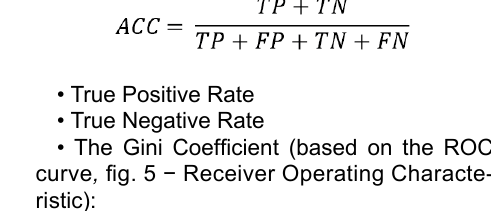
Fig. 4. Division into training and test sets. On the left − a random division used for model data, on the right − a spatial division used for actual data